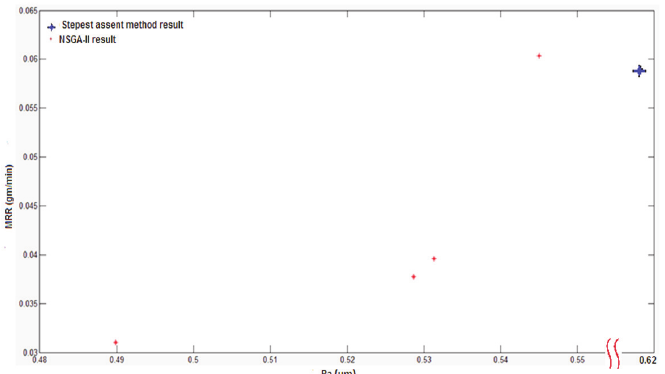
Fig. 3 Pareto optimal front and comparison of result for USM process